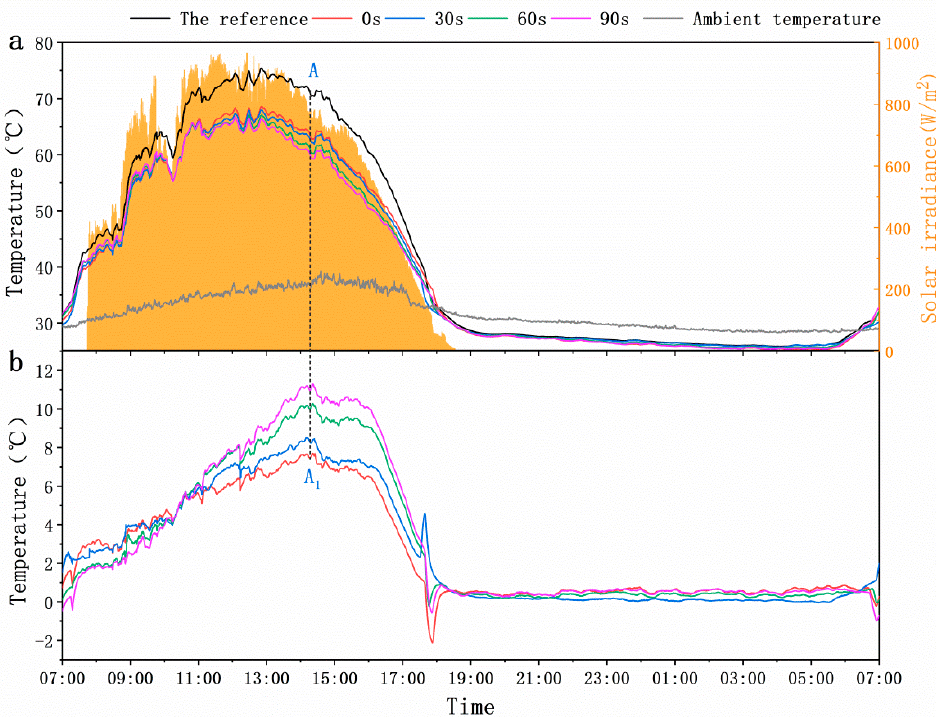
Figure 8. Cooling performance test: ( a ) temperature changes in 24 hours in test boxes covered with no fi lm or fi lms prepared by ZnO-NPs with plasma treatment for 0 s, 30 s, 60 s and 90 s; and ( b ) corresponding cooling e ff ect for the boxes with di ff erent fi lms.